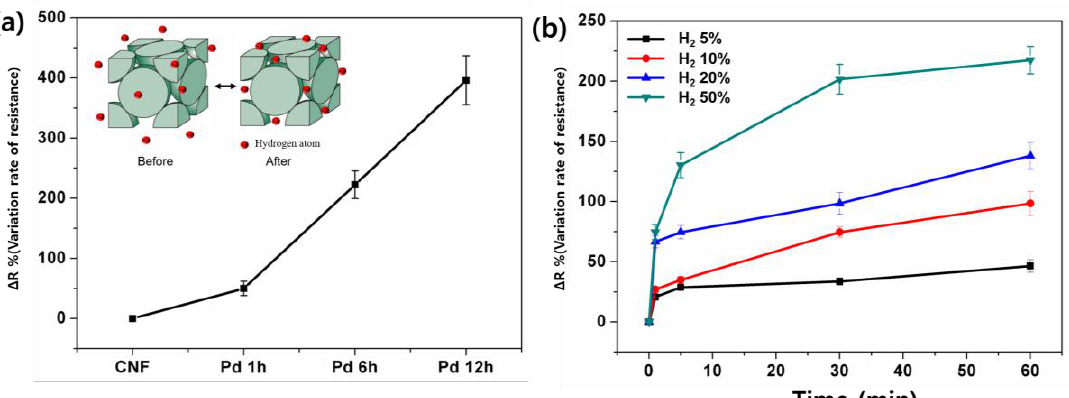
Figure 4. Magnified Pd/CNFs with different deposition time ( a , b ) 1 h; ( c , d ) 6 h; ( e , f ) 12 h is presented. The morphology changes are shown ( a , c , e ) before and ( b , d , f ) after hydrogen adsorption.